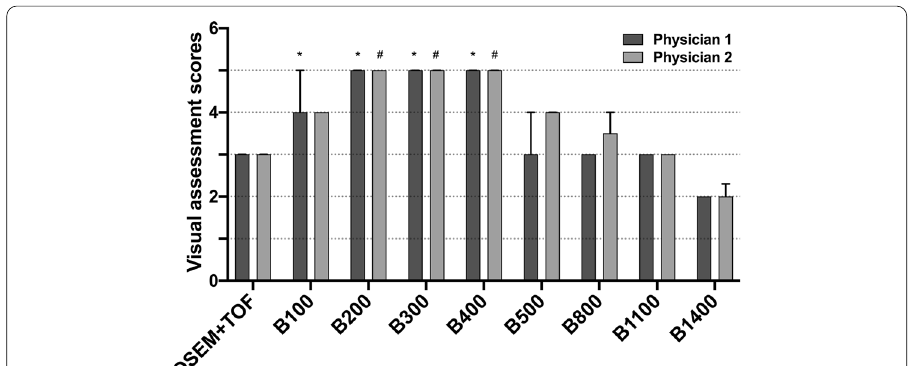
Fig. 4 The differences between the visual assessment scores among the PET images of torso oncologic patients with different reconstruction algorithms. These were shown for OSEM TOF (3 iterations, 28 subsets, + 4.0-mm filter), Q.Clear ( β 100, 200, 300, 400, 500, 800, 1100 and 1400). Values are presented as medians = (IQRs). * and # represent statistical difference compared to OSEM TOF for physician 1 and physician 2, + respectively (Bonferroni corrected P <